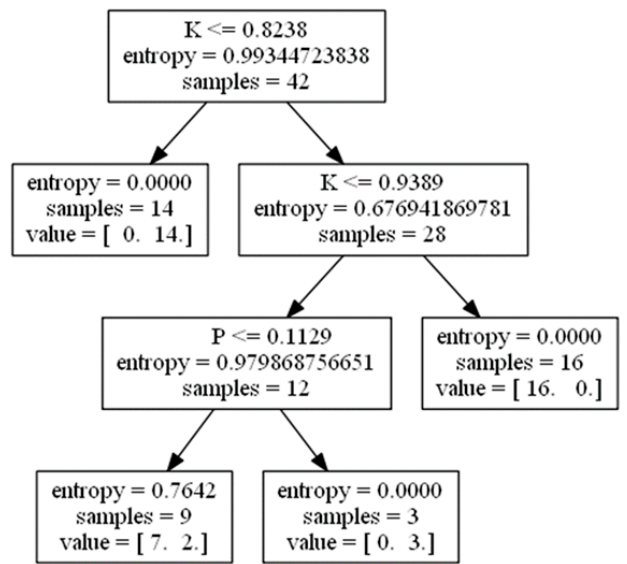
Fig. 17: Decision tree model using only XRF analysis data